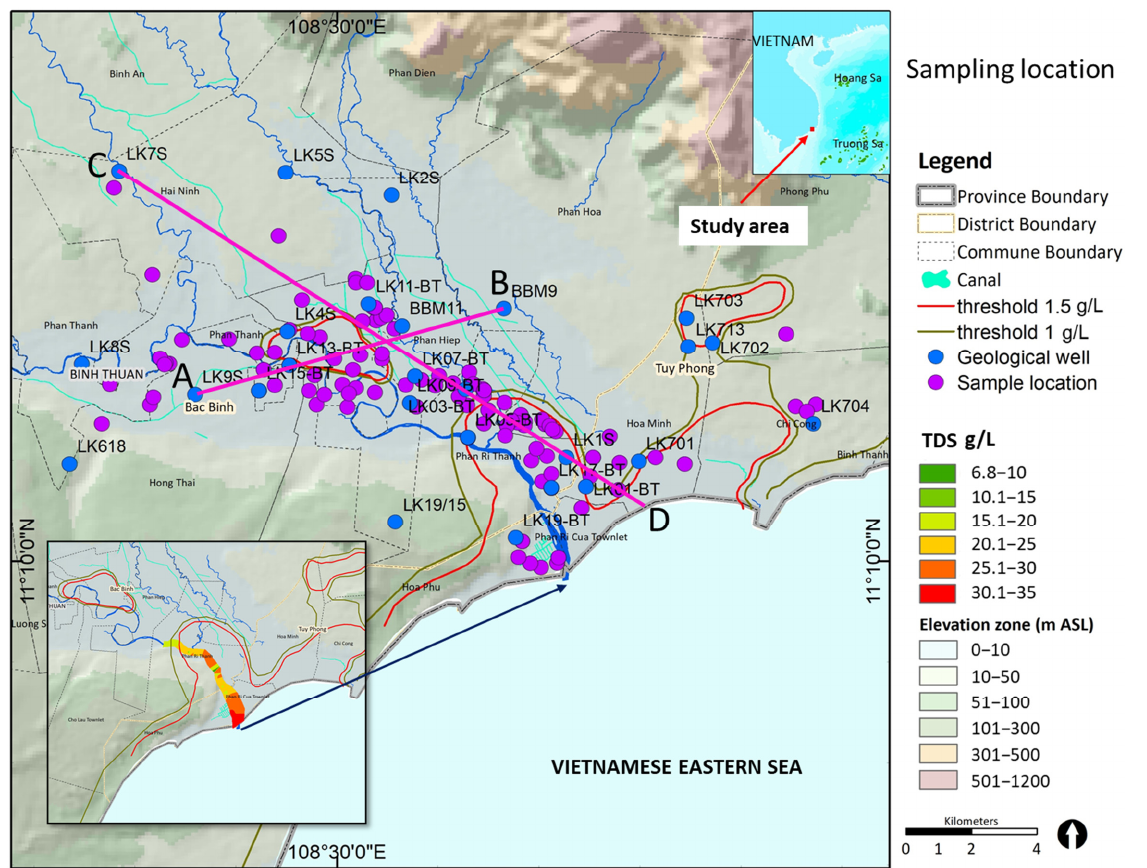
Figure 1. The location of the study area with the topography, sample location and TDS measurement in the Phan Ri river mouth in the summer of 2019; AB and CD solid cross section lines.